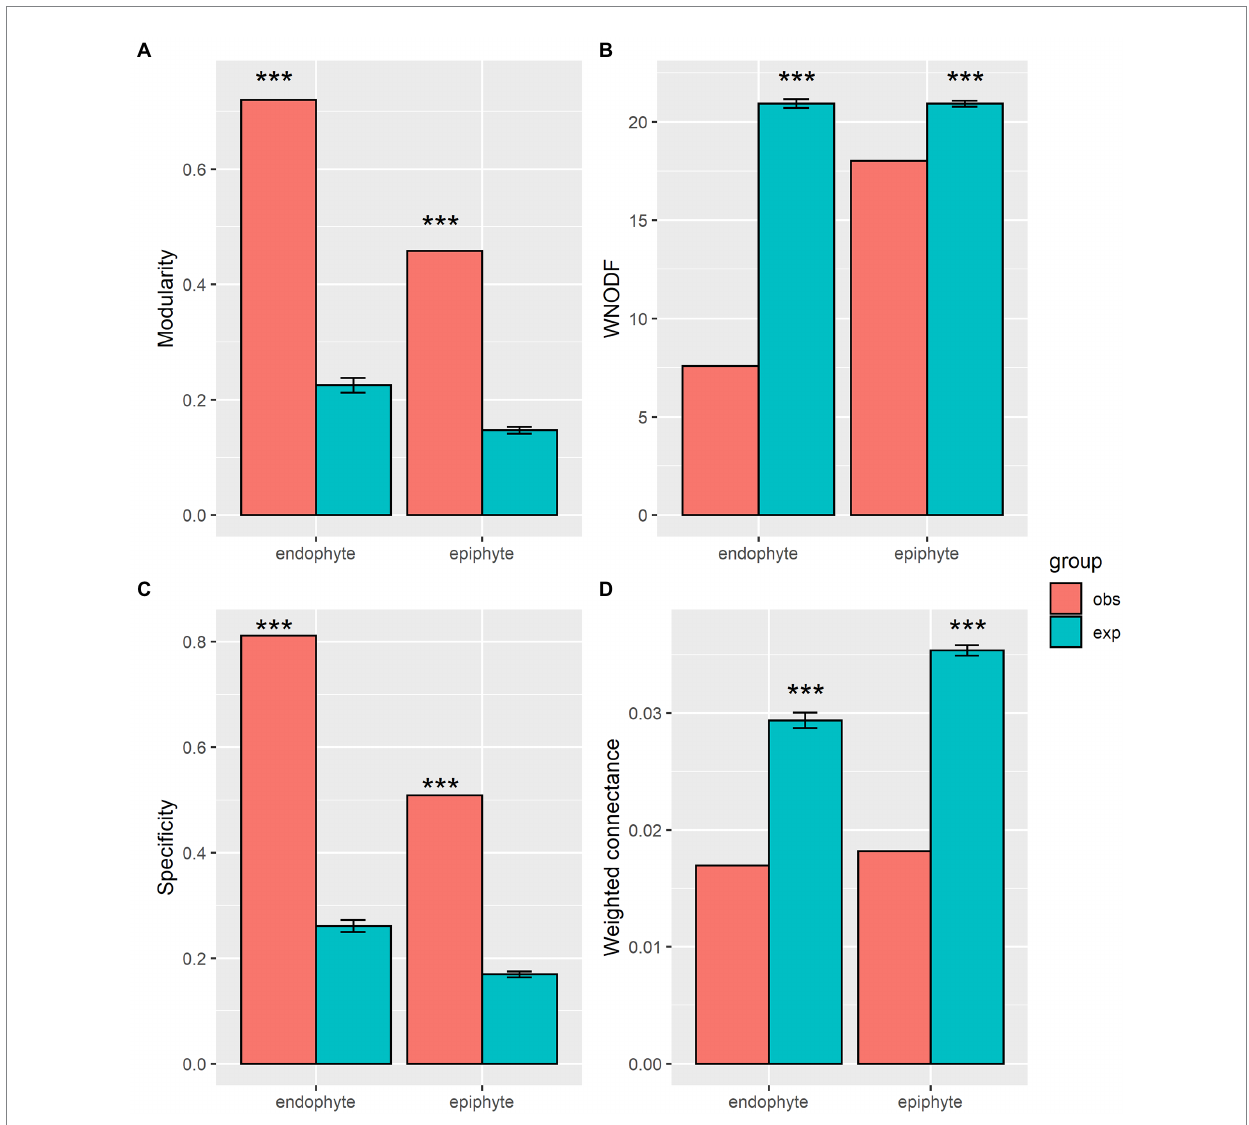
FIGURE 5 Network structural properties of plant-endophytic fungi and plant-epiphytic fungi. Network structures include modularity (A) , weighted nested [WNODF, (B) ], specificity (C) , and weighted connectance (D) . Observation values (obs) of network metrics in our plant-fungal networks and expectation values (exp) and standard errors of that in 1,000 randomized networks, and significance level (* p < 0.05, ** p < 0.01, *** p < 0.001) are shown in the